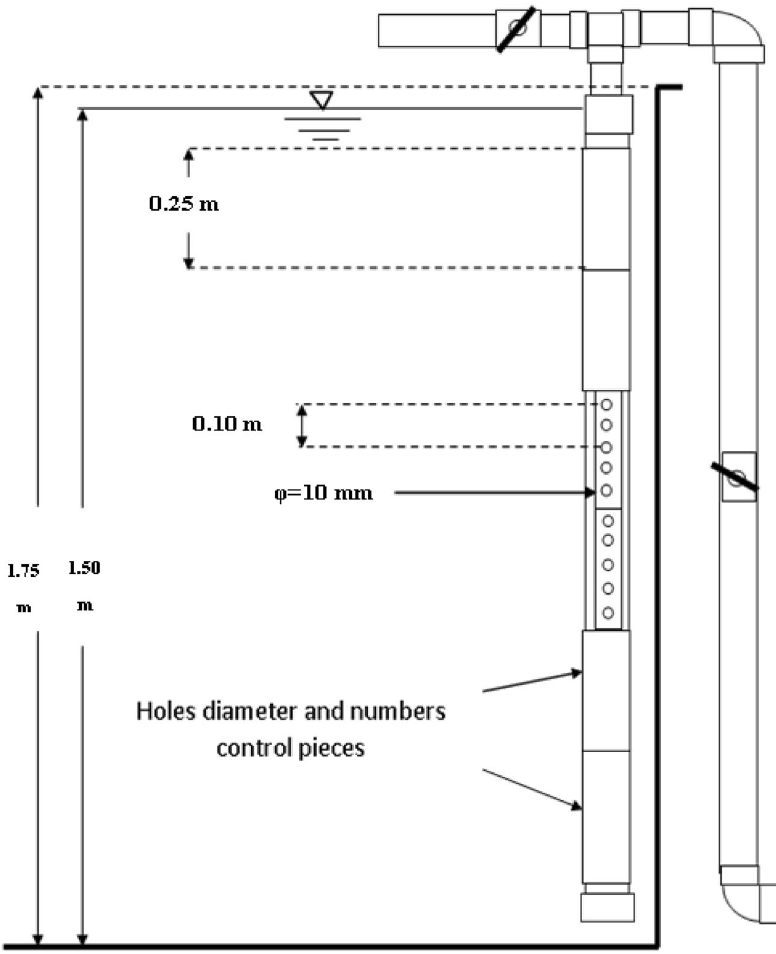
Figure 2. Submerged water jet.